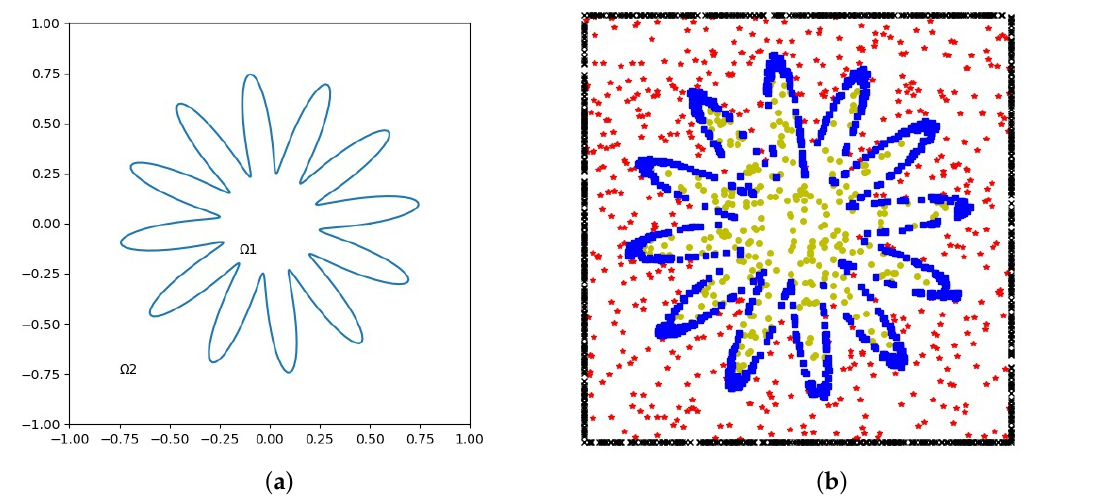
Figure 5. ( a ) Domain and interface geometry and ( b ) training points.